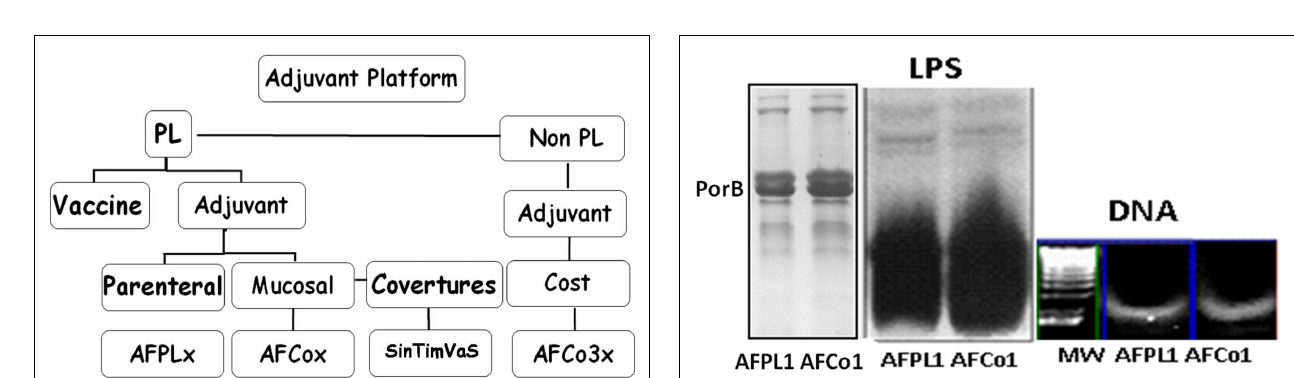
FIGURE 1 | Finlay adjuvant platform . PL, proteoliposome, nanovesicles extracted from bacterial outer membrane (OMV); AFPLx, adjuvant Finlay PLx extracted from different bacteria; AFCo (Cochleate)x obtained from PLx; STVS, single-time vaccination strategy; AFCo3, Co obtained from non-derived-PL structure.